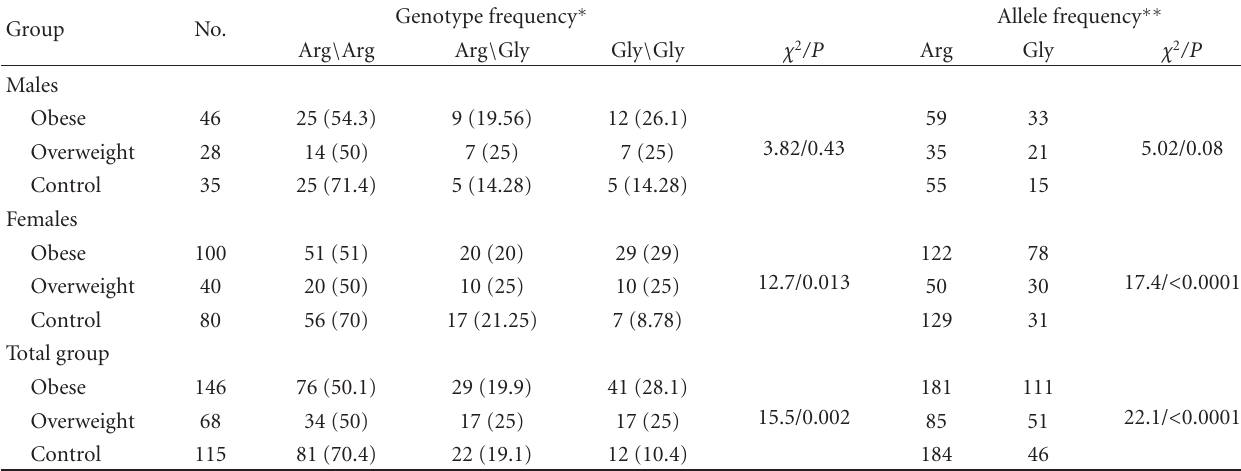
Table 3: Distribution of the genotypes, allele frequencies, and odd ratio of the β 2 Arg16Gly polymorphism in total control, overweight, and obese subjects, separately in males and females.